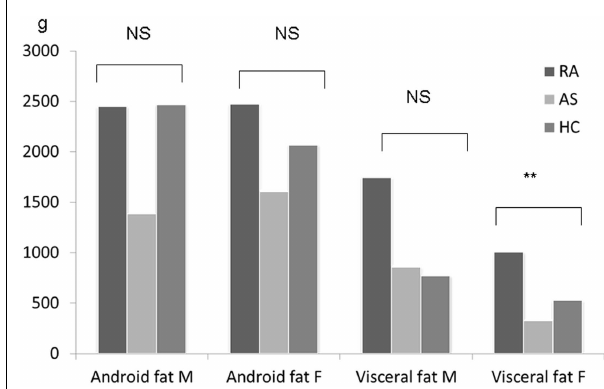
FIGURE 1 | Measurement of fat in the android and visceral regions in patients with rheumatoid arthritis ( N = 30), ankylosing spondylitis ( N = 31), and healthy controls ( N = 51) . Results are given for men and women. Comparisons were performed using the Kruskal–Wallis test; ** p ≤